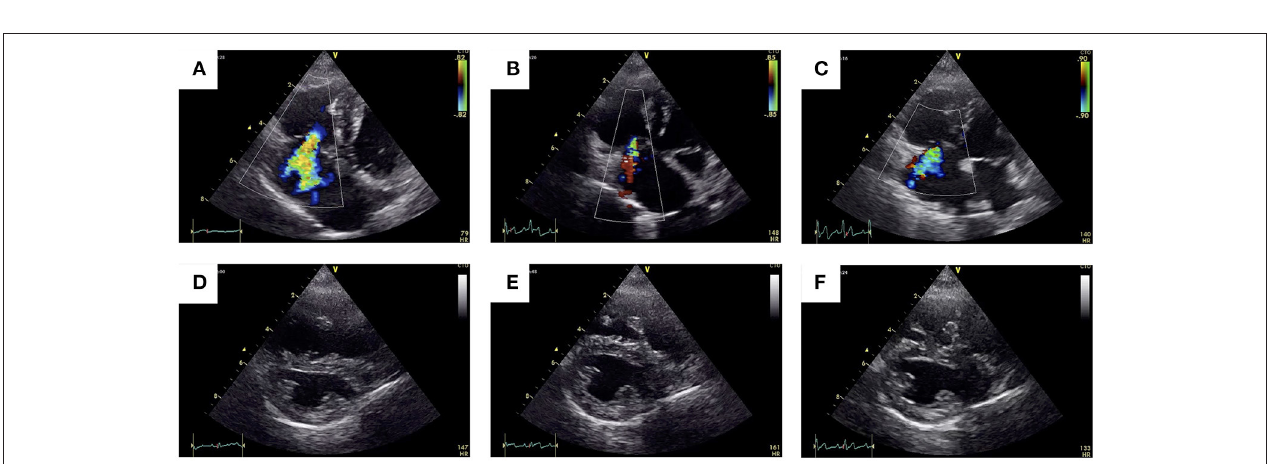
FIGURE 4 | Pre-operative vs. post-operative transthoracic echocardiographic images. The 2-D color Doppler image of the tricuspid regurgitant jet obtained through the left apical imaging window (A–C) and of the flattening of the interventricular septum obtained using right parasternal short-axis views (D–F)